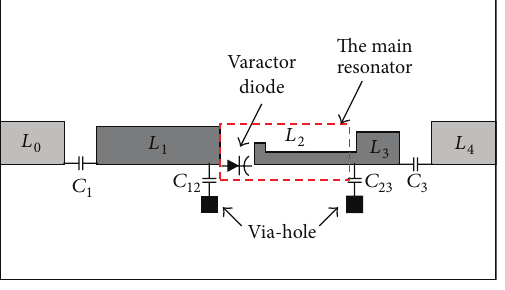
Figure 1: The tunable bandpass filter.